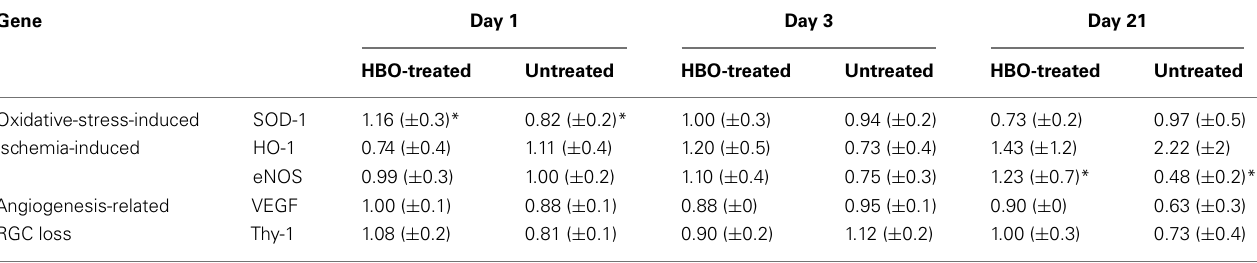
Table 2 | Expression of oxidative-stress-induced, ischaemia-induced, and angiogenesis-related genes following rAION induction at various time points, with and without HBO